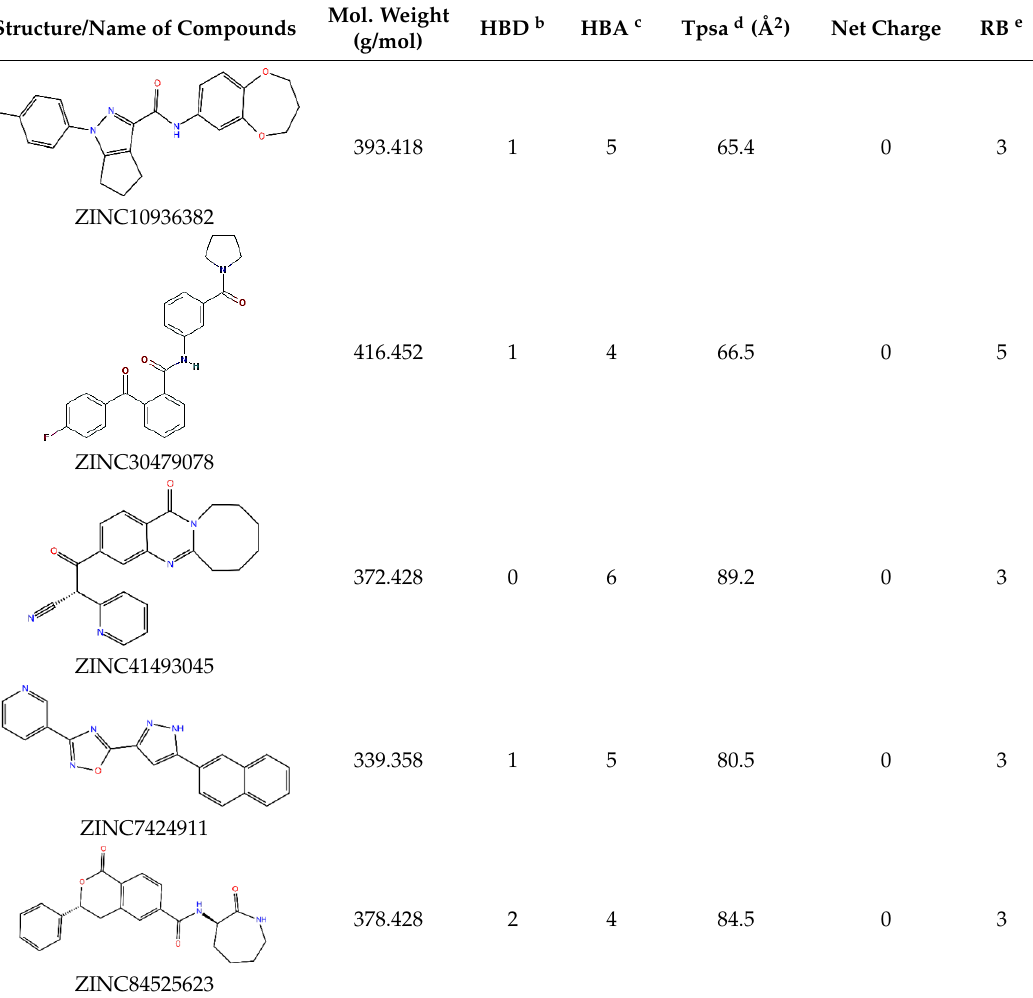
Table 2. The physiochemical properties (PubChem database) of the top 5% selected compound through a XP docking scores.